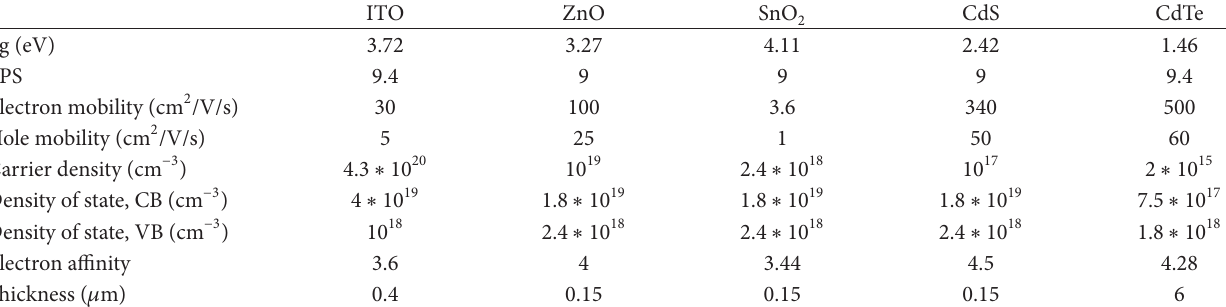
T 1: e parameters used in the AMPS-1D simulation.